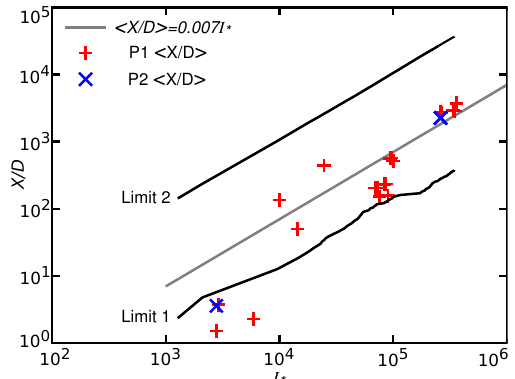
Figure 9. Mean displacement data for the first (red + ) and second (blue x) populations of tracer particles vs. dimensionless impulse ( I ∗ ). The gray line is the linear relationship determined by Phillips et al. (2013). The black lines represent the upper and lower limits of sediment particle transport (see Sect. 2.1 for discussion of limits). The data plotting below limit 1 have unrealistic values for I ∗ (see Sect. 3.3 for